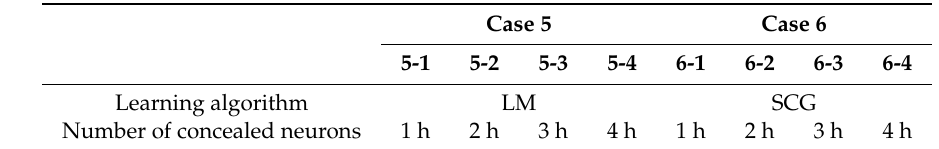
Table 3. ANN model by model